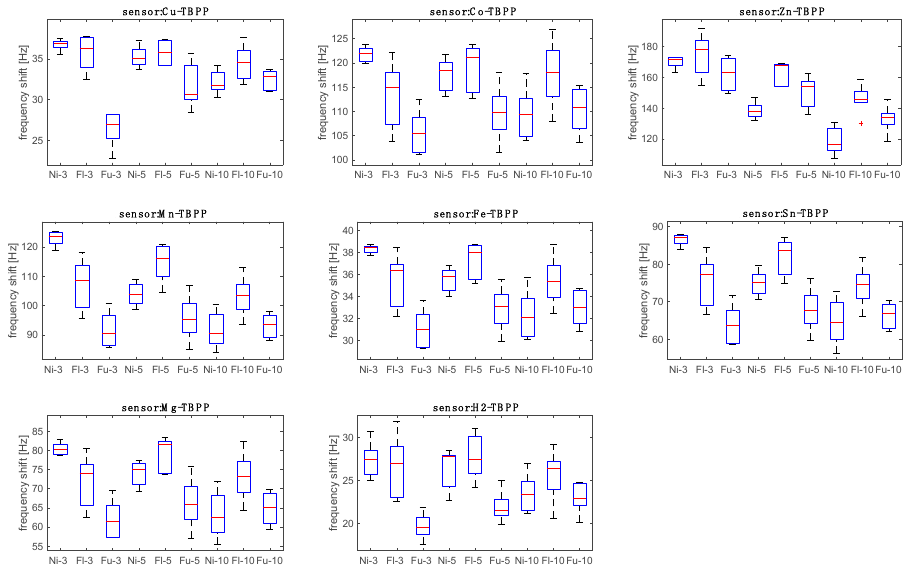
Figure 5. The distributions of the responses of sensors in the nine groups are represented by box-plots. Groups are labeled with the initials of the strain (Ni, Flu, and Fu) and a number (3, 5, 10) indicating the days since inoculation. For a description of the box-plot details, see the caption of Figure 4.